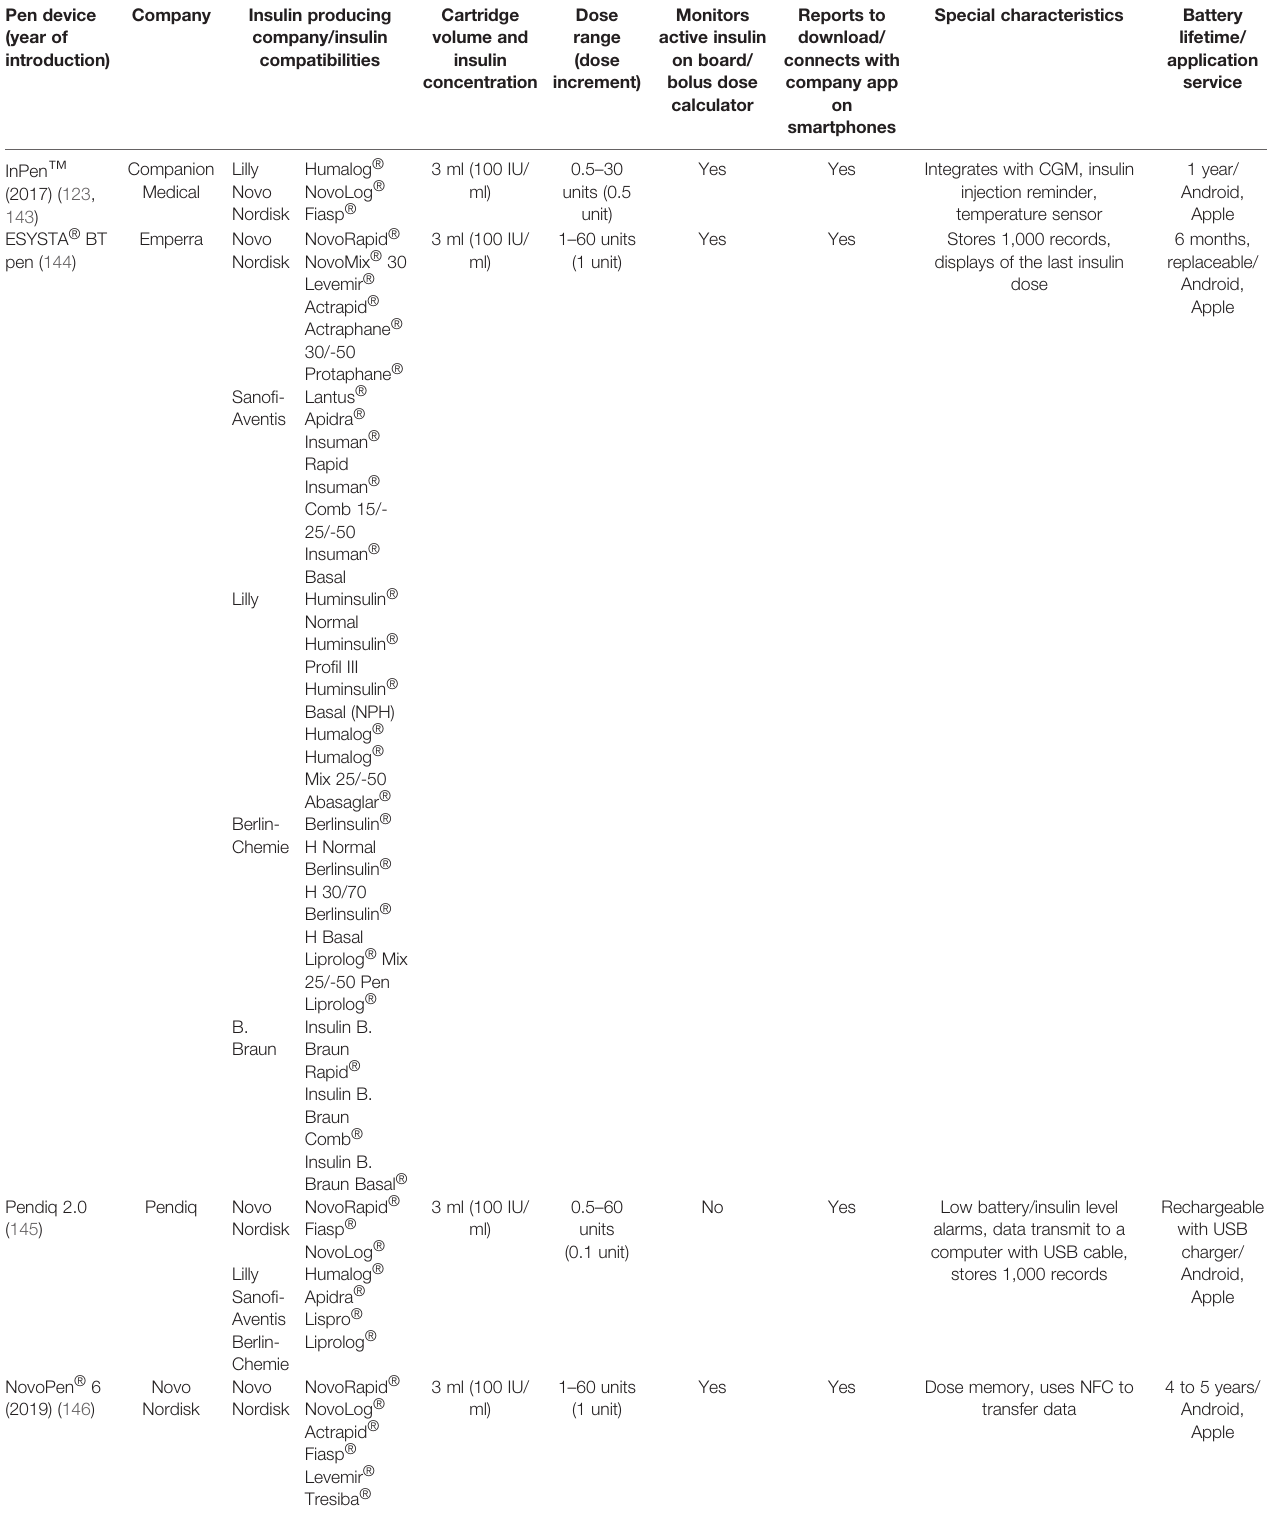
TABLE 6 | Technical characteristics of smart insulin